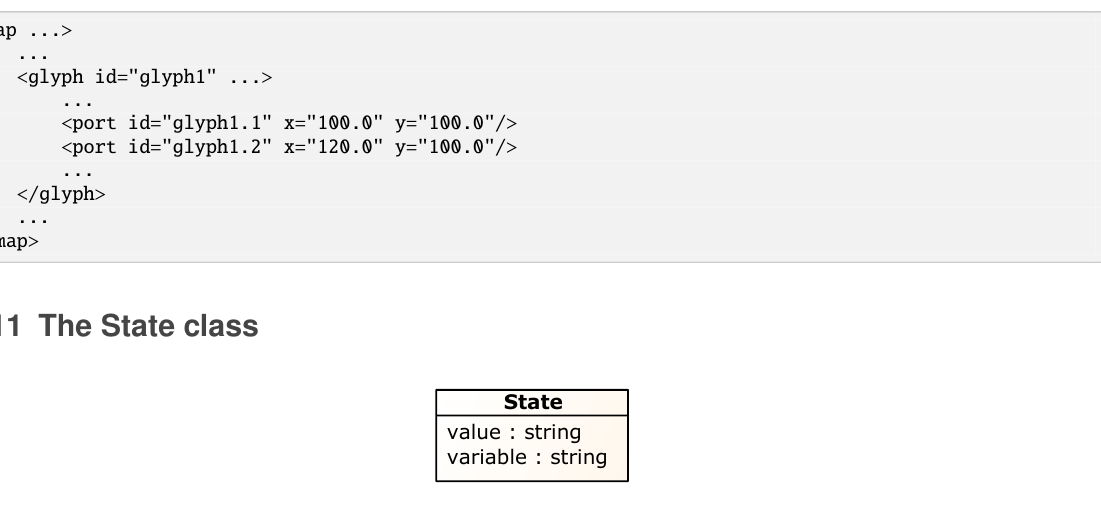
Figure 17: A UML representation of the State class for the Systems Biology Graphical Notation - Markup Language. See Section 2.1 for conventions related to this figure.